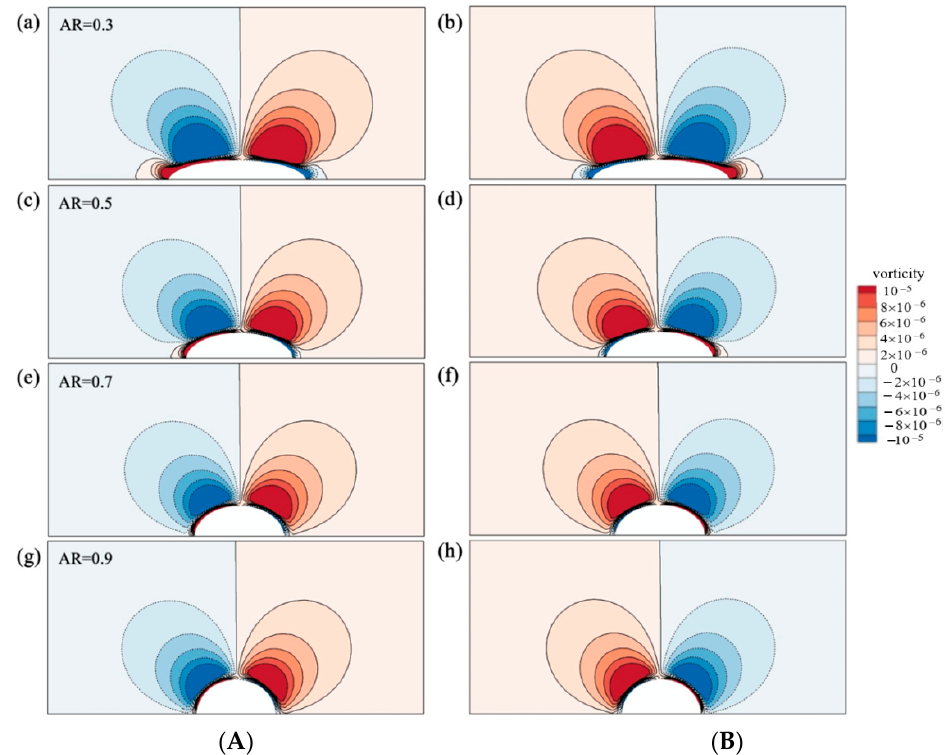
Figure 12. Vortical contours induced by elliptical squirmer with different ARatRe = 0.01. ( a ,b) Re = 0.3, ( c , d ) Re = 0.5, ( e , f ) Re = 0.7, ( g , h ) Re = 0.9. ( A ) pusher ( β = − 5) for different AR. ( B ) puller ( β = 5) for different